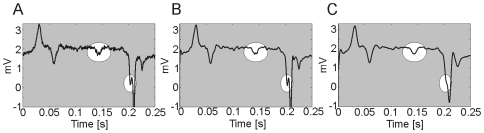
A pump filtered using two filters with different cut-off frequencies.A. The raw signal (unfiltered). B. The signal after being filtered with the 200 Hz cut-off filter. C. The signal after being filtered with the 100 Hz cut-off filter.